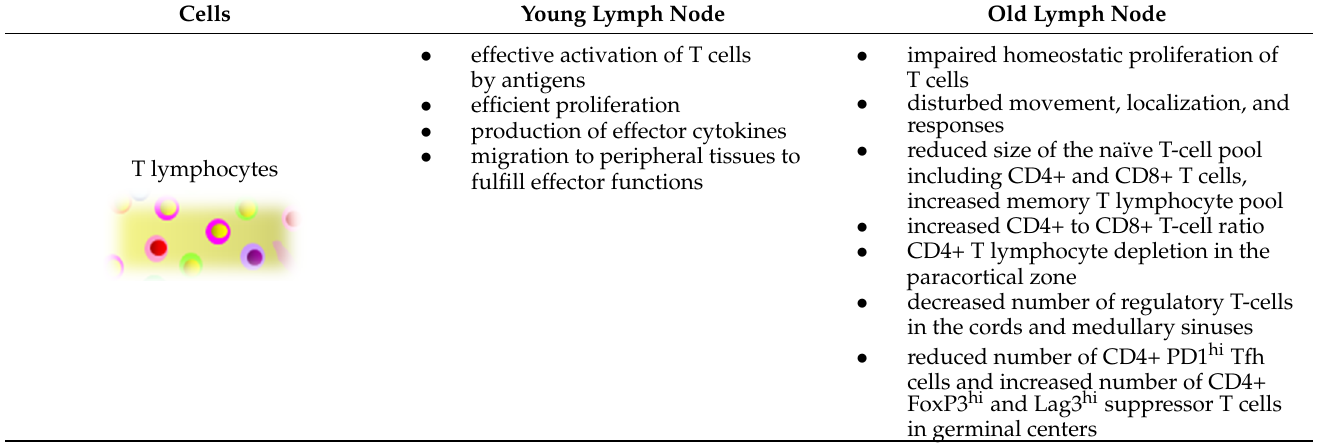
Table 2. Summary of aging-related changes in the structure and function of lymphocytes and neutrophils in the lymph nodes. Cells